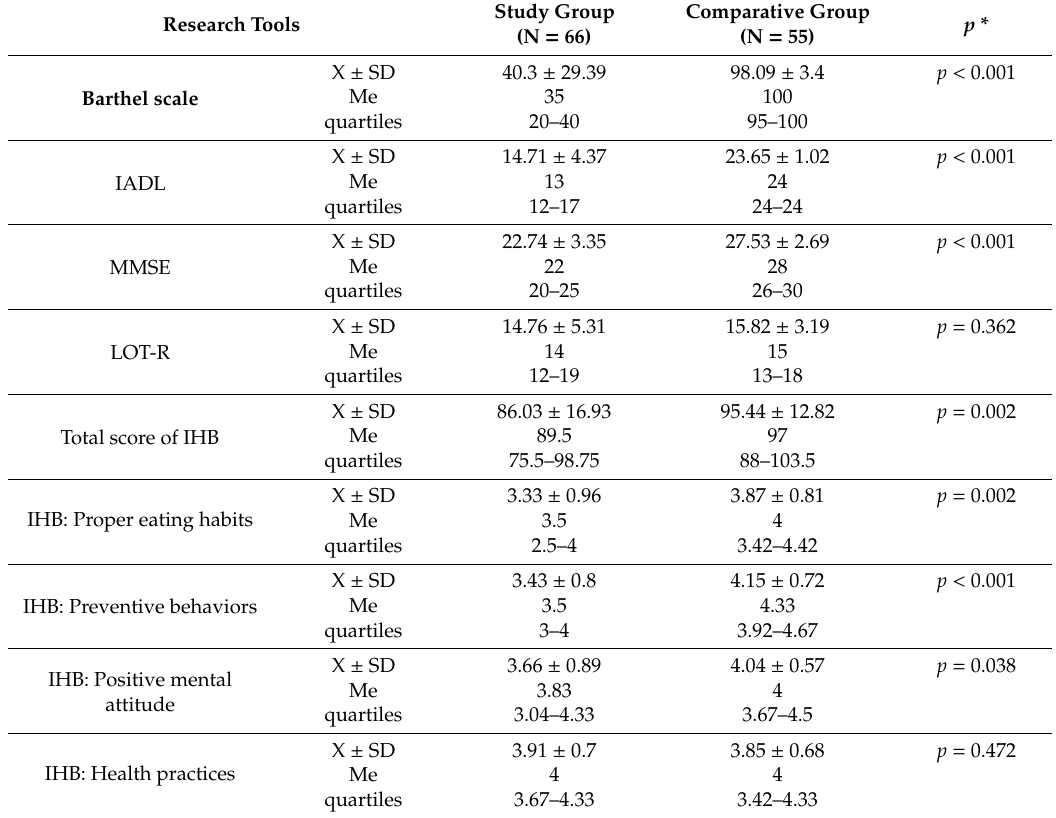
Table 2. The comparison of study participants in terms of functional, cognitive and emotional skills and lifestyle using standardized research